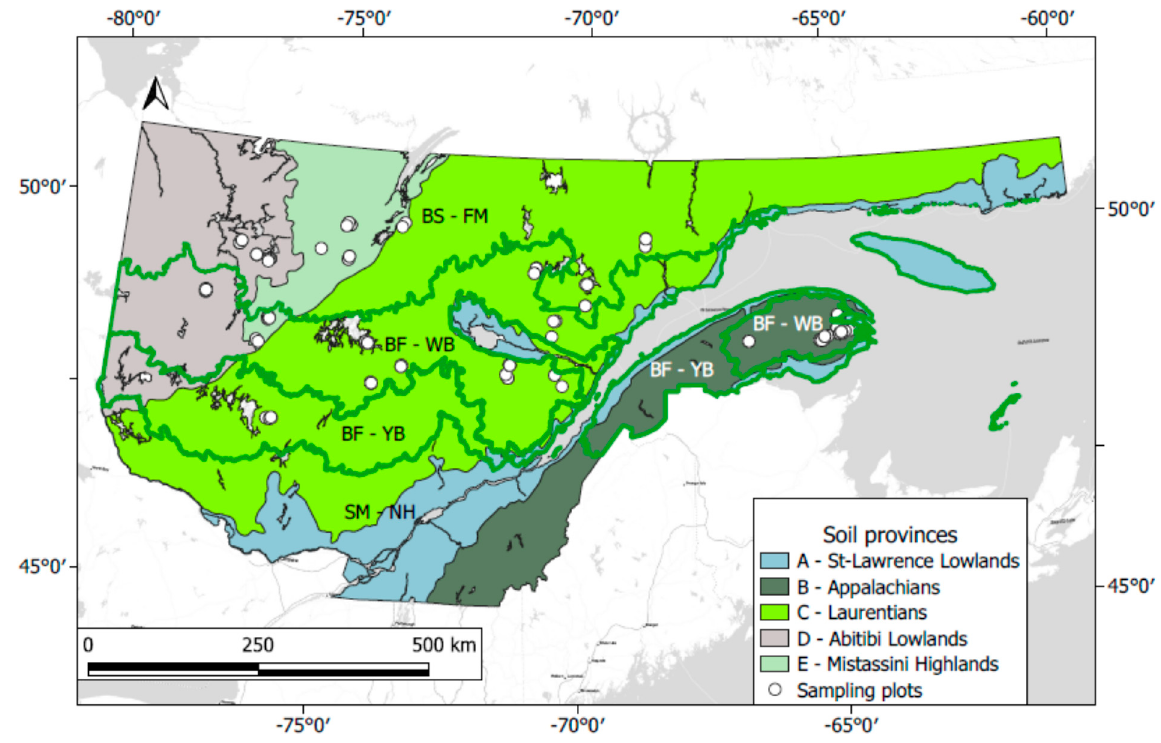
Figure 1. Map of sampling plot locations. Colored areas show the soil provinces of Quebec (Canada). Green lines delimit vegetation bioclimatic domains: SM-NH: sugar maple northern hardwoods; BF-YB: balsam fir–yellow birch domain; BF-WB: balsam fir–white birch domain; BS-FM: black spruce–feather moss domain. Table 1. Characteristics of the four soil provinces of Quebec included in the study